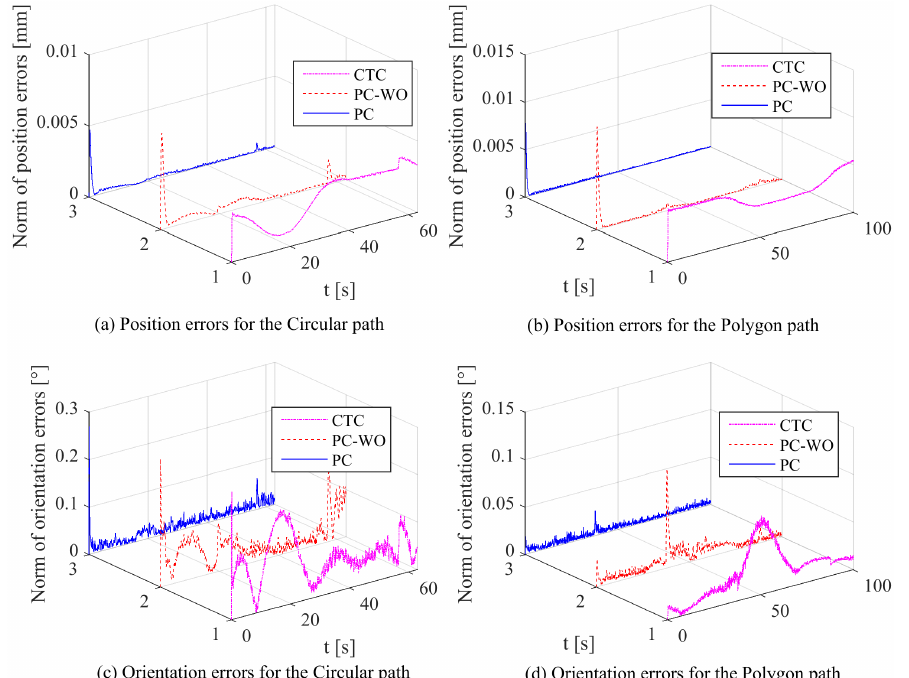
Figure 7. Time trajectories of the norm of tracking errors.